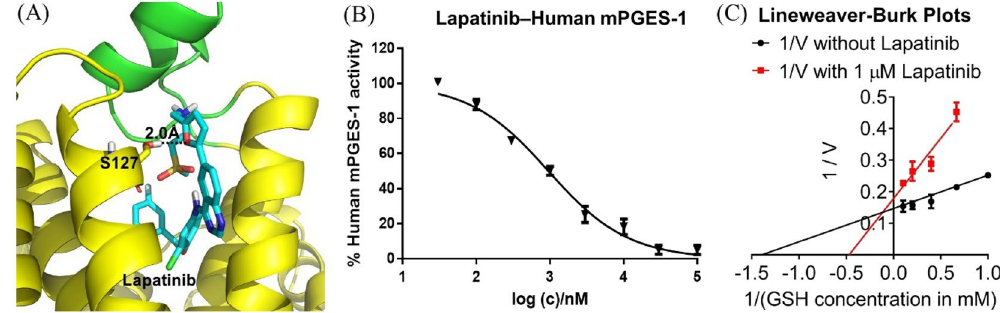
Figure 1. ( A ) Modelled binding structure of lapatinib (cyan sticks) with mPGES-1 (yellow cartoon) obtained by using the crystal structure (4AL0). The cap domain is colored in green and some key residues interacting with lapatinib are showed in sticks. Hydrogen bond is showed in black dashed line. ( B ) Dose-dependent inhibition of lapatinib against mPGES-1. ( C ) Inhibition of mPGES-1 with lapatinib at constant 1 µ M concentration and GSH at different concentrations, showing that lapatinib is a GSH-competitive